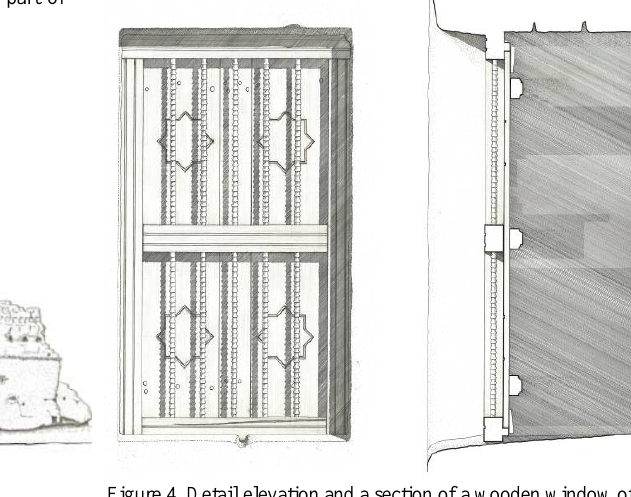
Figure 2. A sectional elevation of Bin Bidowah Tower Hosue in Al Qattara Oasis (original 1:50) produced by Finnish architect